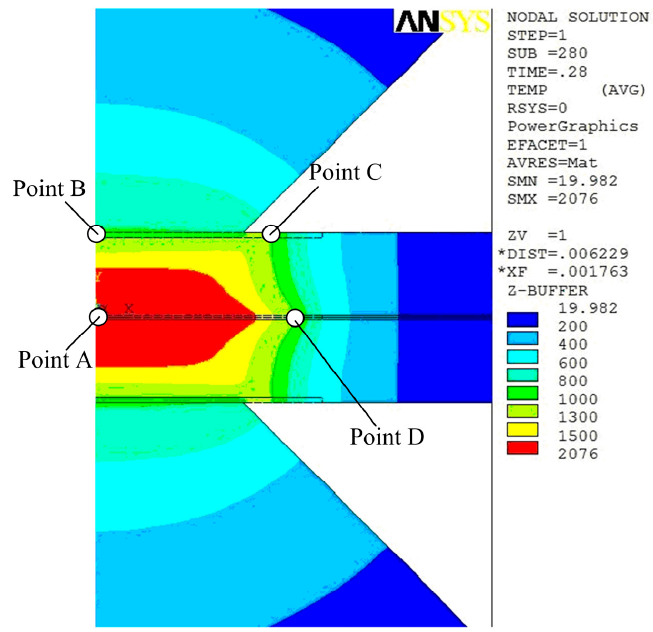
Figure 12. Four key points selected.